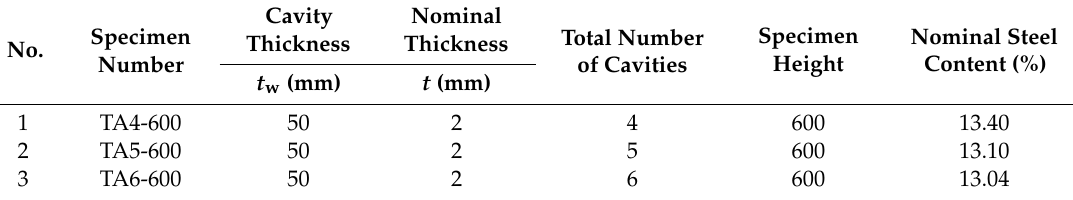
Figure 1. Cross-sectional dimension of T-shaped four-cavity T-shaped concrete-filled steel tube shear wall (CFSTSW) (unit: mm). Table 1. Main design parameters of the test specimen.